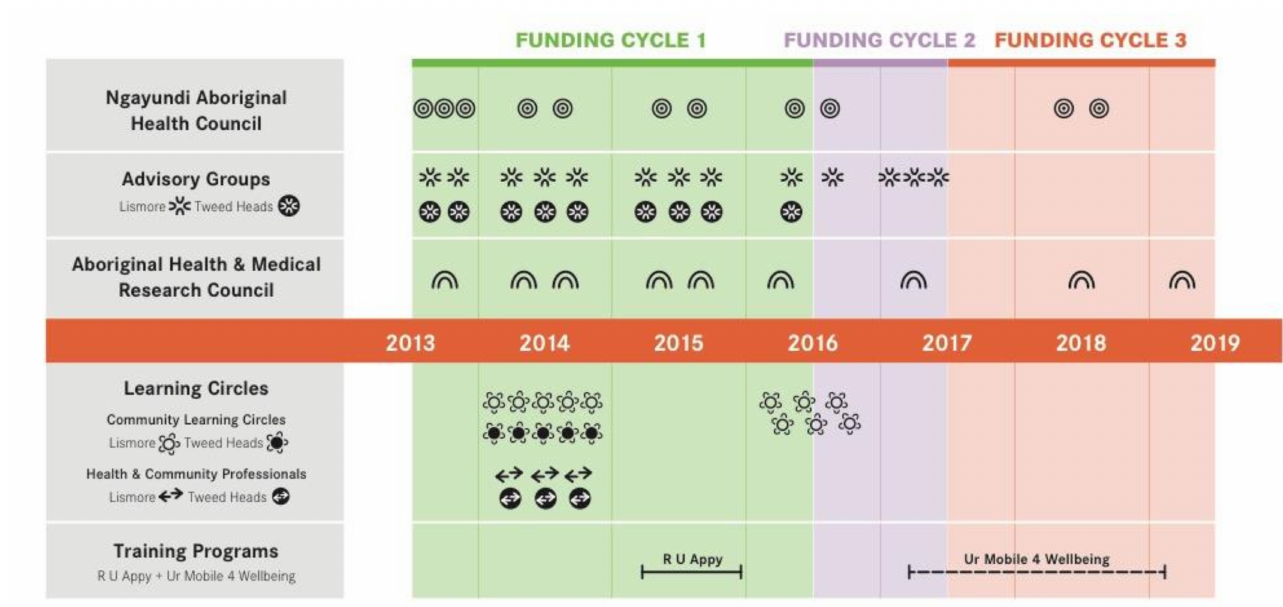
Figure 1. Number of meetings or sessions attended by the five community